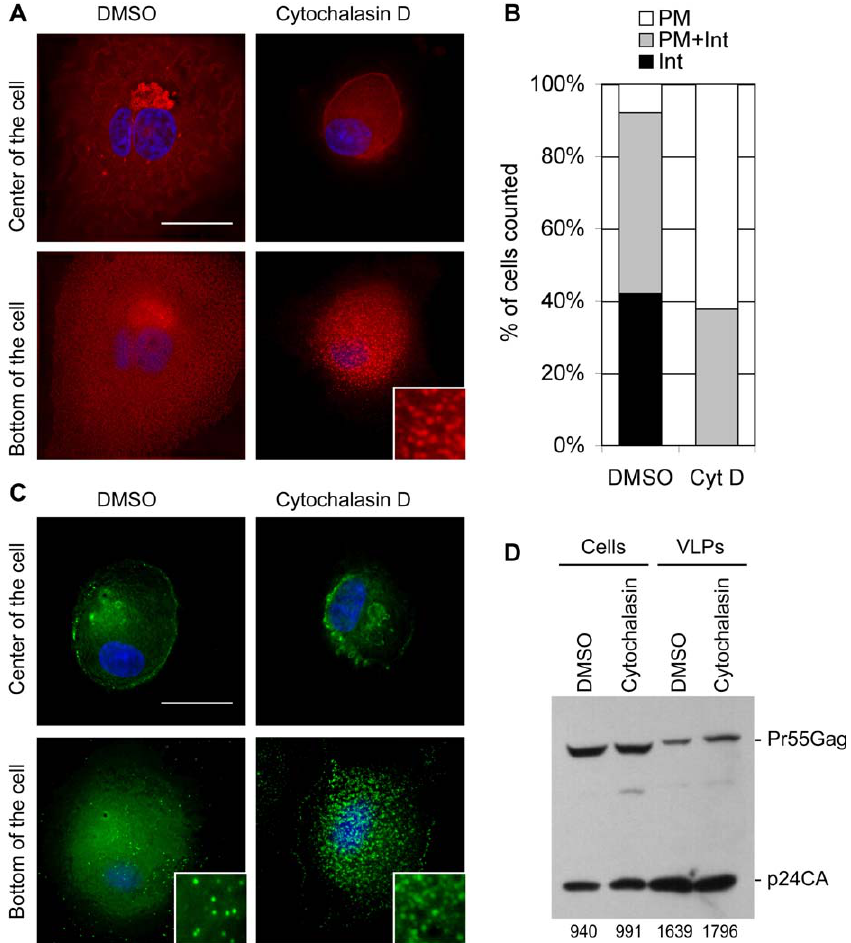
Figure 10. Actin Influences HIV-1 Gag Localization but Not Particle Release in Infected Macrophages (A) Immunofluorescent detection of HIV-1 CA in macrophages, 38 h after infection by pseudotyped NL4–3 (Env (cid:2) ). Deconvolved optical sections acquired at the center of the vertical dimension of the cell, and at the cell–coverslip interface are shown for examples of infected cells cultured in the presence of DMSO or cytochalasin D. Cells were stained with anti–HIV-1 CA antibodies (red) and Hoechst 33258 (blue). Inset shows expanded view at the PM–coverslip interface and individual Gag puncta. Scale bar indicates 10 l m. (B) Quantitative analysis of Gag localization in NL4–3 (Env (cid:2) ) infected macrophages. The proportion of cells exhibiting each Gag distribution among 44 to 49 cells counted is plotted. (C) Distribution of Gag in NL4–3 (MA/YFP) infected macrophages, as in (A) except that no immunostaining was done. Inset shows expanded view at the PM–coverslip interface and individual Gag (MA/YFP) puncta. Scale bar indicates 10 l m. (D) Western blot analysis of HIV-1 release from NL4–3 (Env (cid:2) ) infected cells in the presence or absence of cytochalasin D, as indicated. Numerical values below the blots indicate p24CA signal intensities in cells and VLPs, derived by